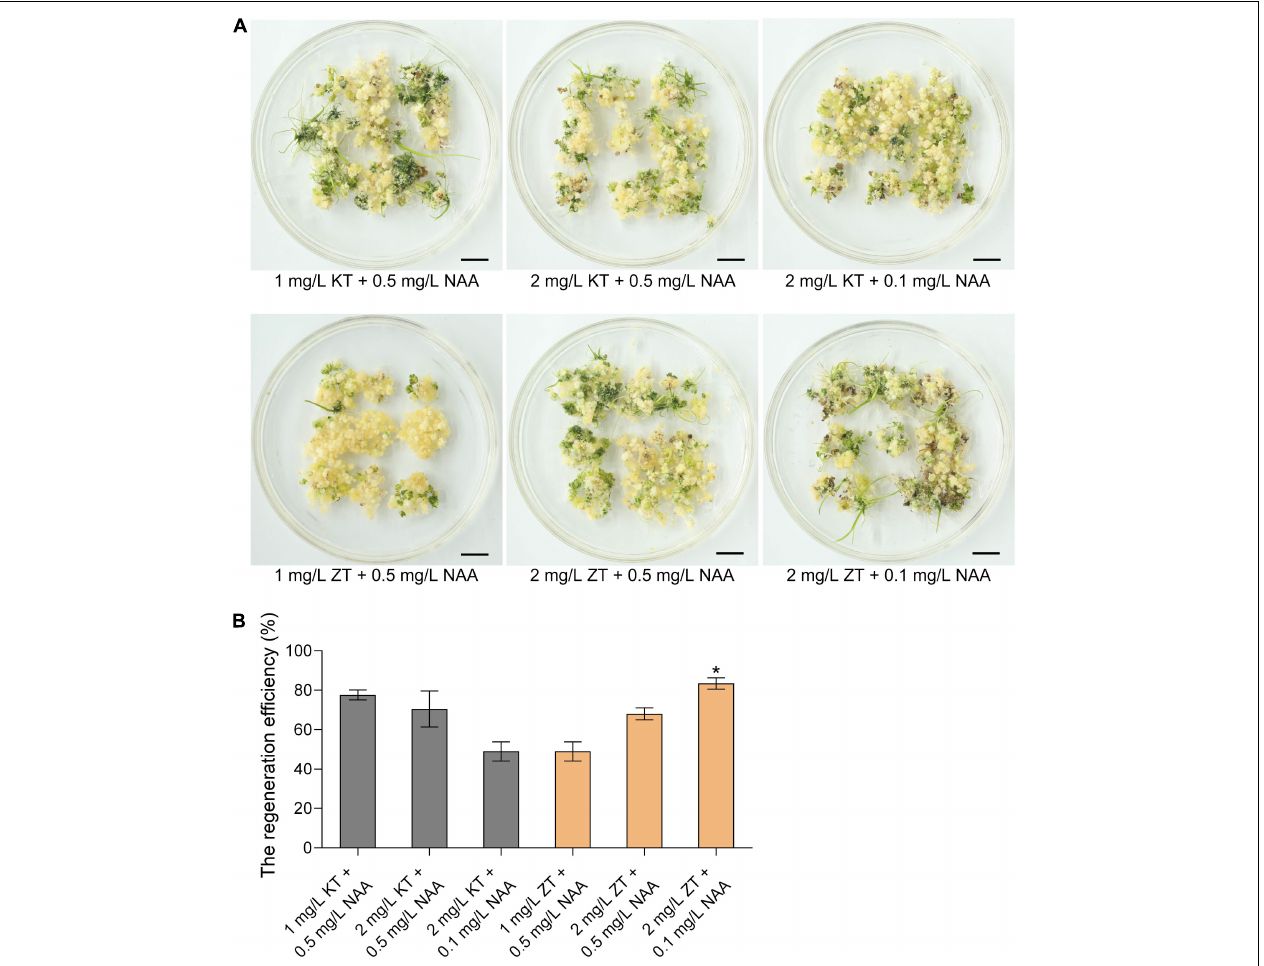
FIGURE 2 | Effects of different combinations of cytokinin and auxin on callus regeneration of CLCWR. (A) Calli of CLCWR were induced on callus induction medium containing 2.5 mg/L 2,4-D for 15 days. Then the calli were transferred to the regeneration medium containing different combinations of cytokinin and auxin for 30 days. Bars = 1 cm. (B) The regeneration efficiency of calli on the regeneration medium containing different combinations of cytokinin and auxin as indicated in (A) . The regeneration efficiency of calli was calculated after regenerating for 30 days. Significant differences were found between 2 mg/L ZT + 0.1 mg/L NAA and other concentration combinations (* P < 0.01 by Student’s t -test). Data are means of three replicates of one experiment. The experiment was repeated three times with similar results. Error bars represent ± SD. Asterisks represent significant